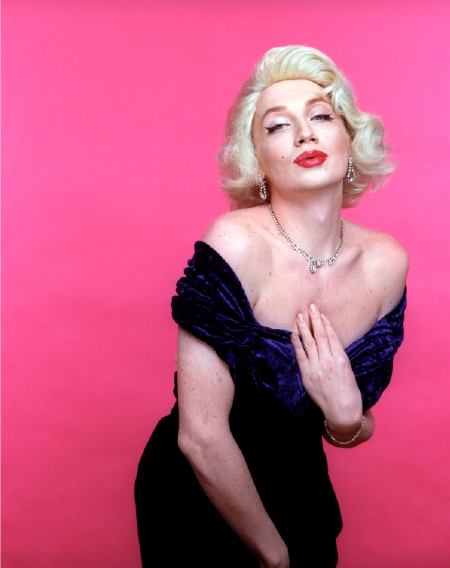
Figure 4. Vlad Mamyshev-Monroe. From the series “Life of Remarkable Monroes” (1995). https: